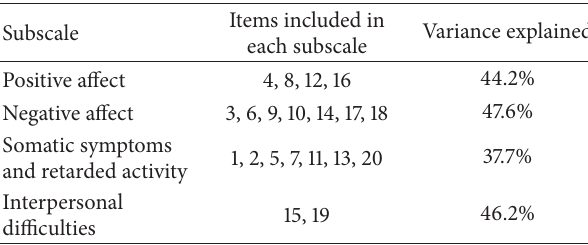
Table 4: Variance explained in each CES-D